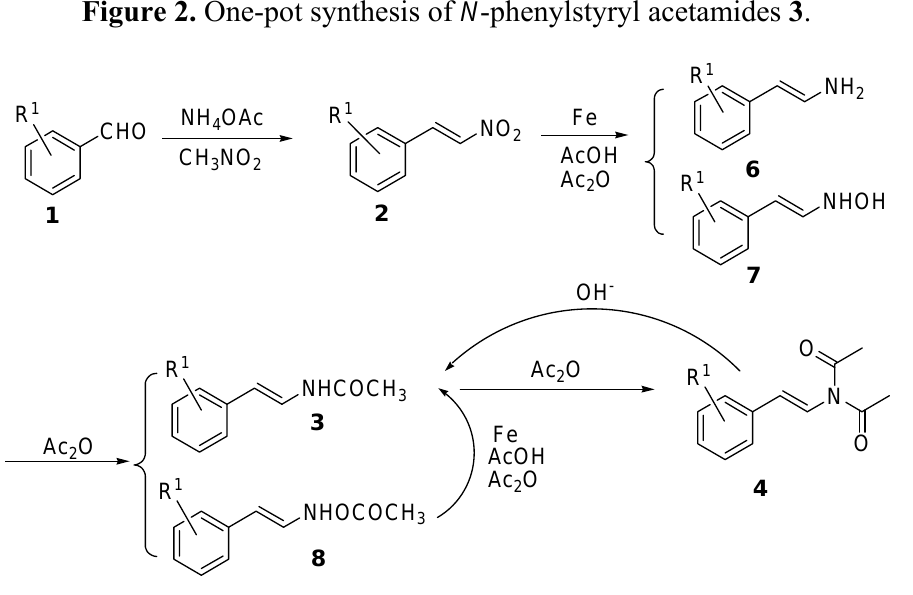
Figure 2. One-pot synthesis of N -phenylstyryl acetamides 3